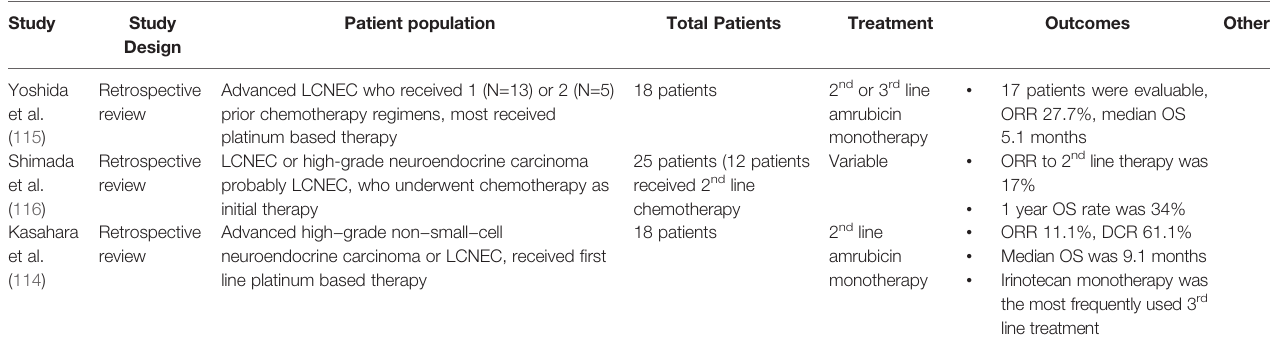
TABLE 9 | Key Papers Describing 2 nd /3 rd Line treatments in Metastatic Pulmonary